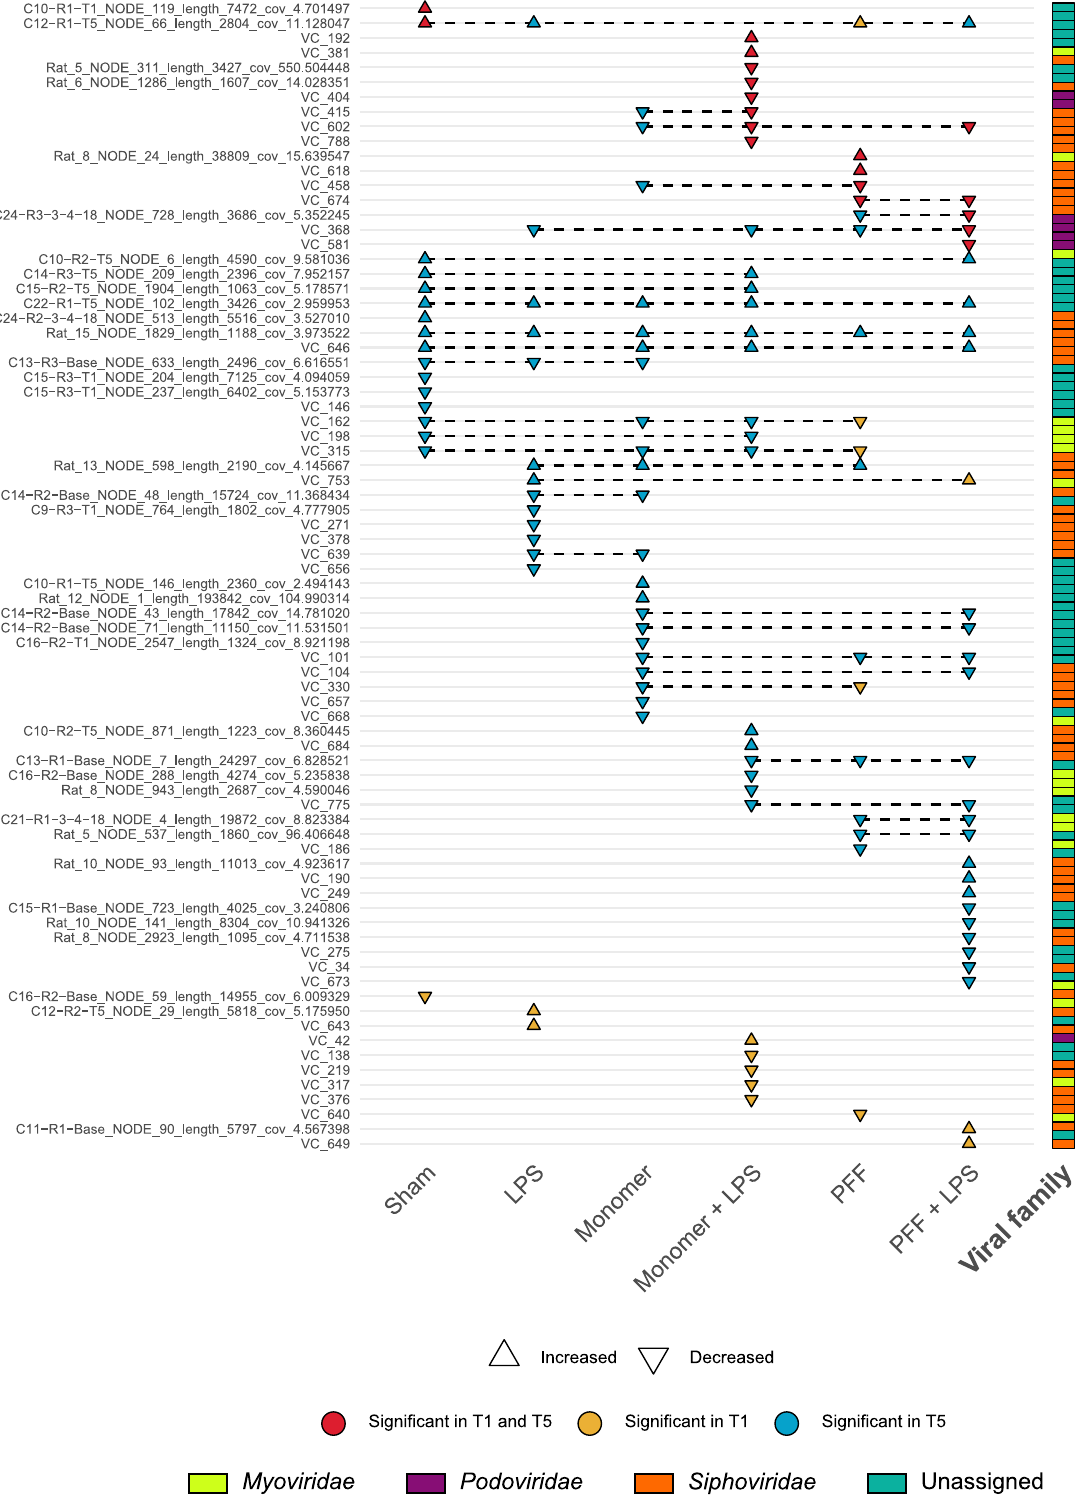
Fig. 6 Viruses and viral clusters which were differentially abundant at statistical signi fi cance in at least one of the study ’ s time points, relative to the baseline. Viruses or viral clusters that were differentially abundant across two or more treatment groups are connected using black dashed lines. The shape of each point indicates if the virus or viral cluster had an increased or decreased differential abundance. The putative familial taxonomic assignment of the various viruses is indicated on the right-hand side of the